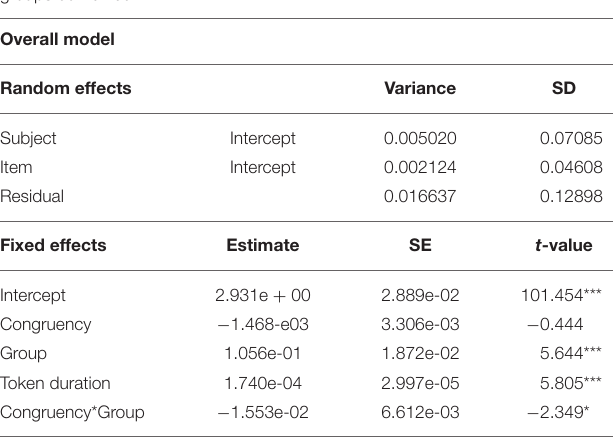
TABLE 3 | Results of the mixed-effects analysis for both English and Chinese groups combined.